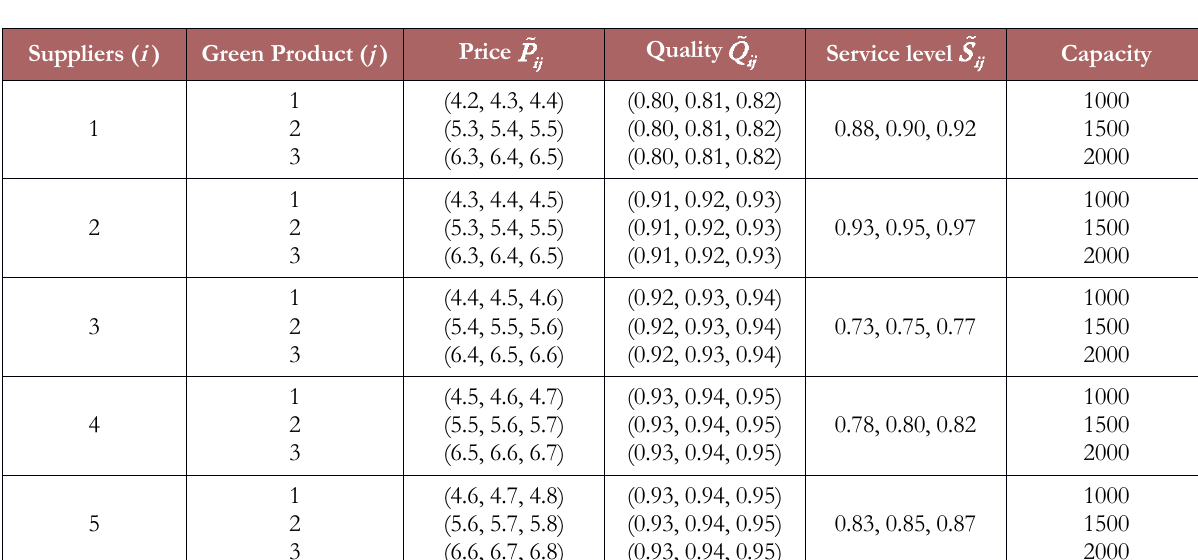
Table 2. Suppliers quantitative